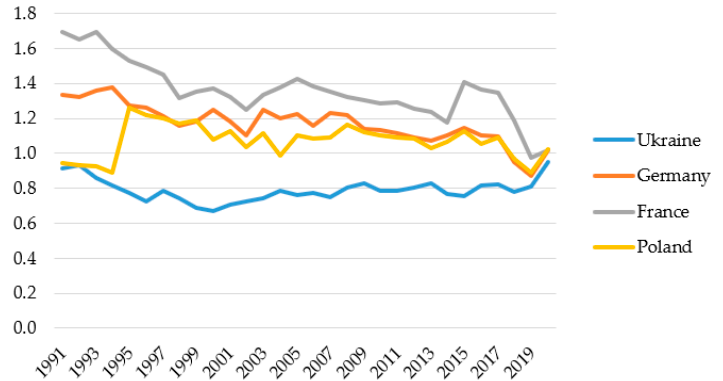
Figure 11. Comparative dynamics of economic security indices of Ukraine, Germany, France, and Poland during 1991–2020.